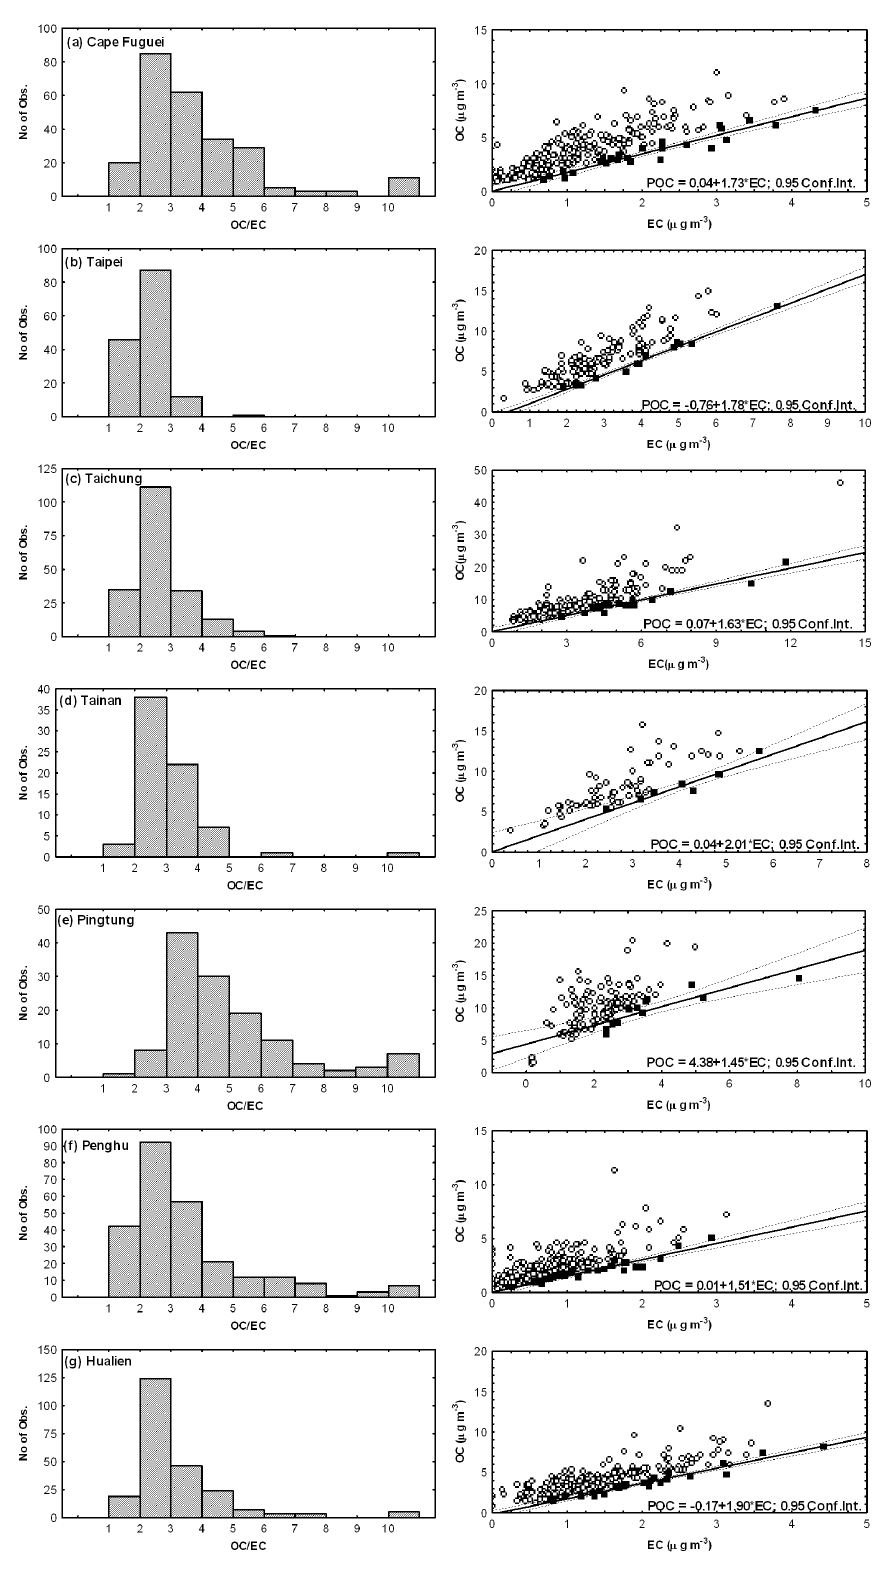
Fig. 3. Same as Fig. 2 but for PM 2 . 5